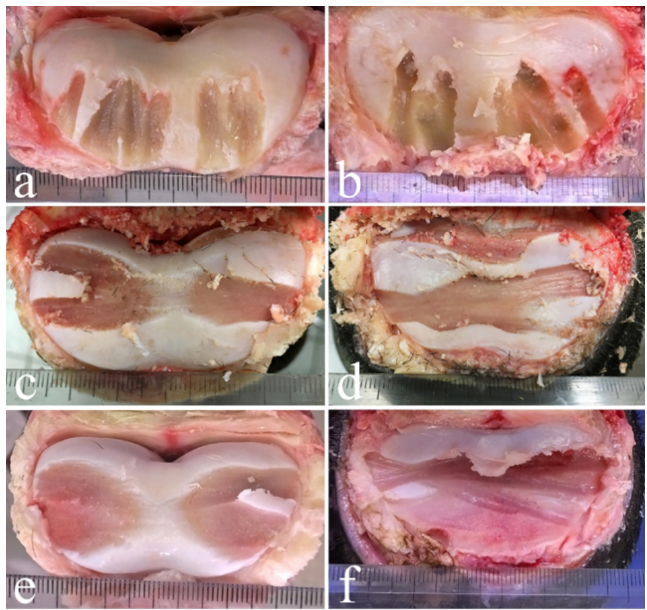
Figure 3. Distal surfaces of P1 ( a , c , e ) and proximal surfaces of P2 ( b , d , f ) of the forelimb after dorsal drilling approach ( a , b ) and lateral drilling approach without ( c , d ) and with the use of digital fluoroscopy ( e , f ). The best cases, belonging to three different animals and obtained with the three different drilling techniques, are shown.